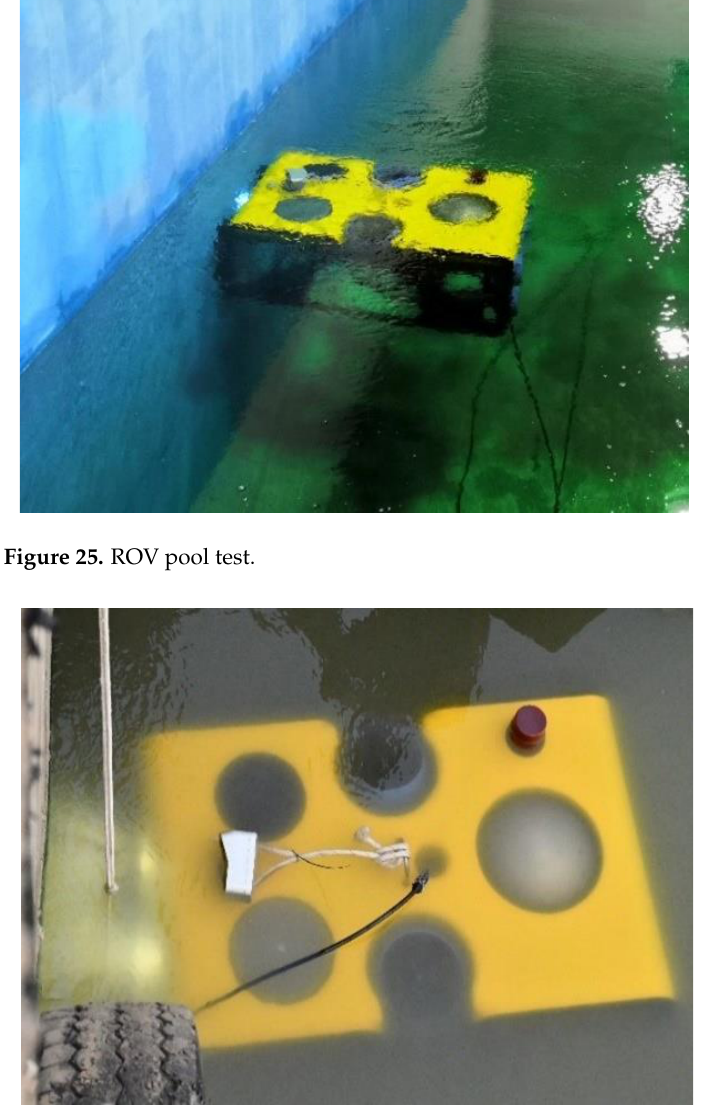
Figure 26. ROV wharf test.